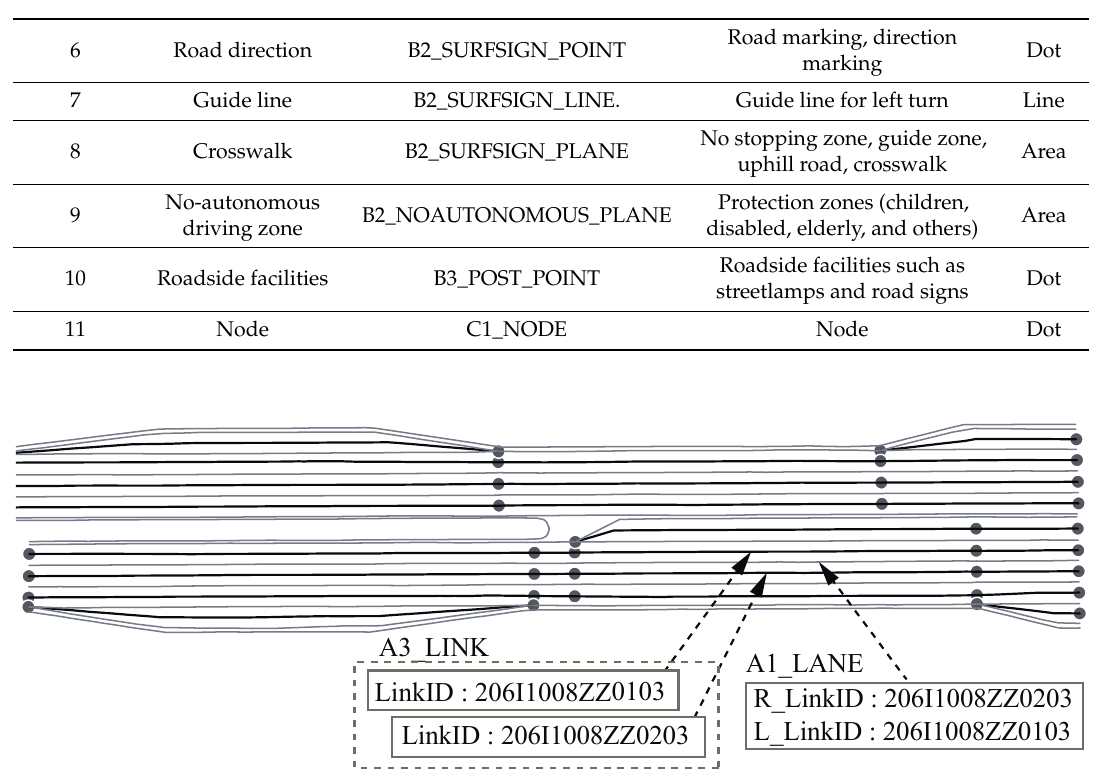
Figure 2. Link relationships between different layers in a high-precision road map.